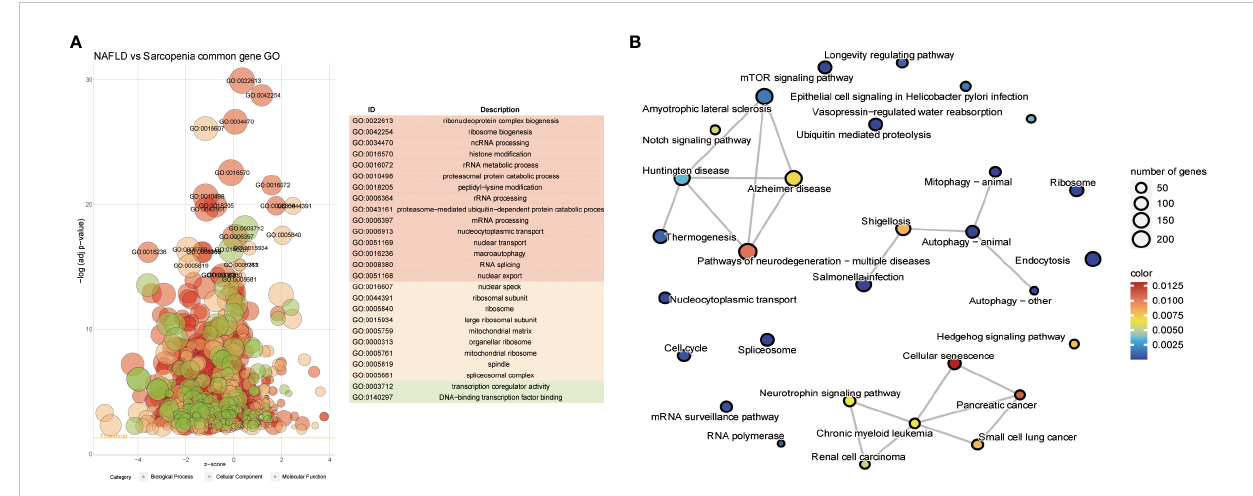
FIGURE 5 Common Genes Analyses in NAFLD and Sarcopenia. (A) The GO term of all common genes in NAFLD and Sarcopenia; (B) The KEGG of all common genes in NAFLD and